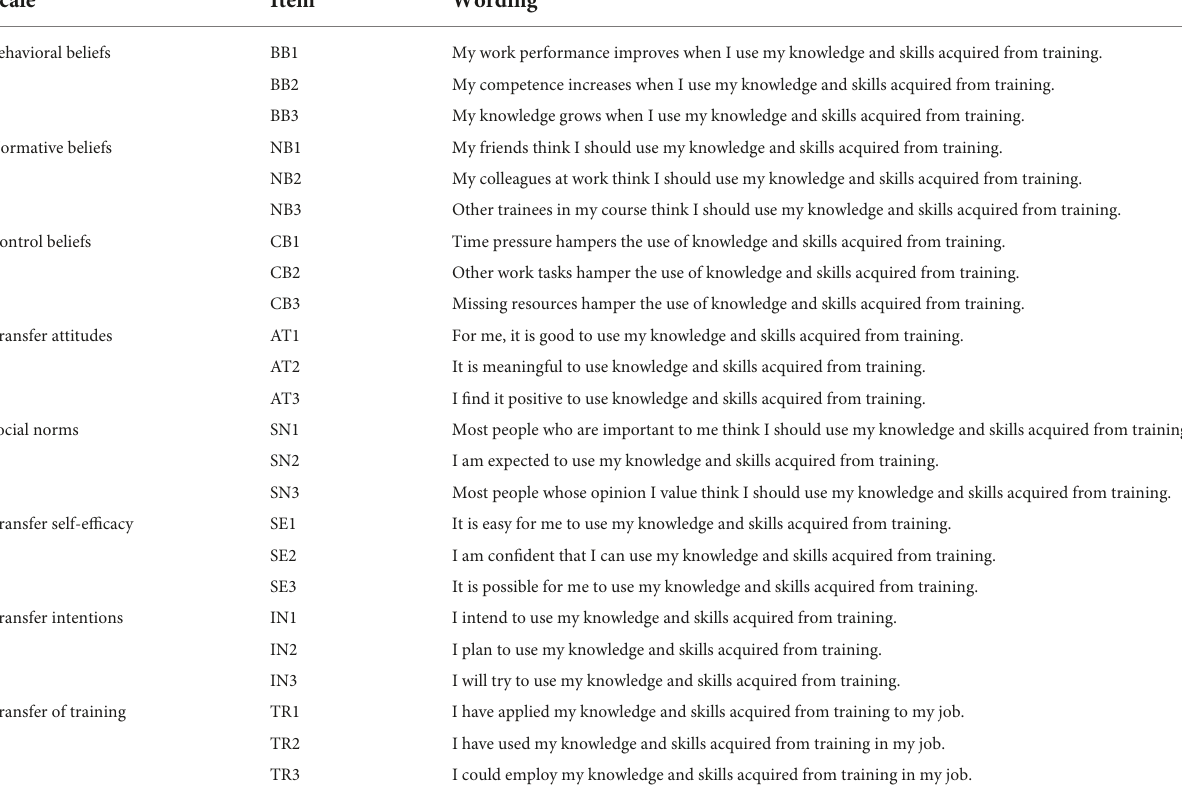
TABLE 1 Wording of all